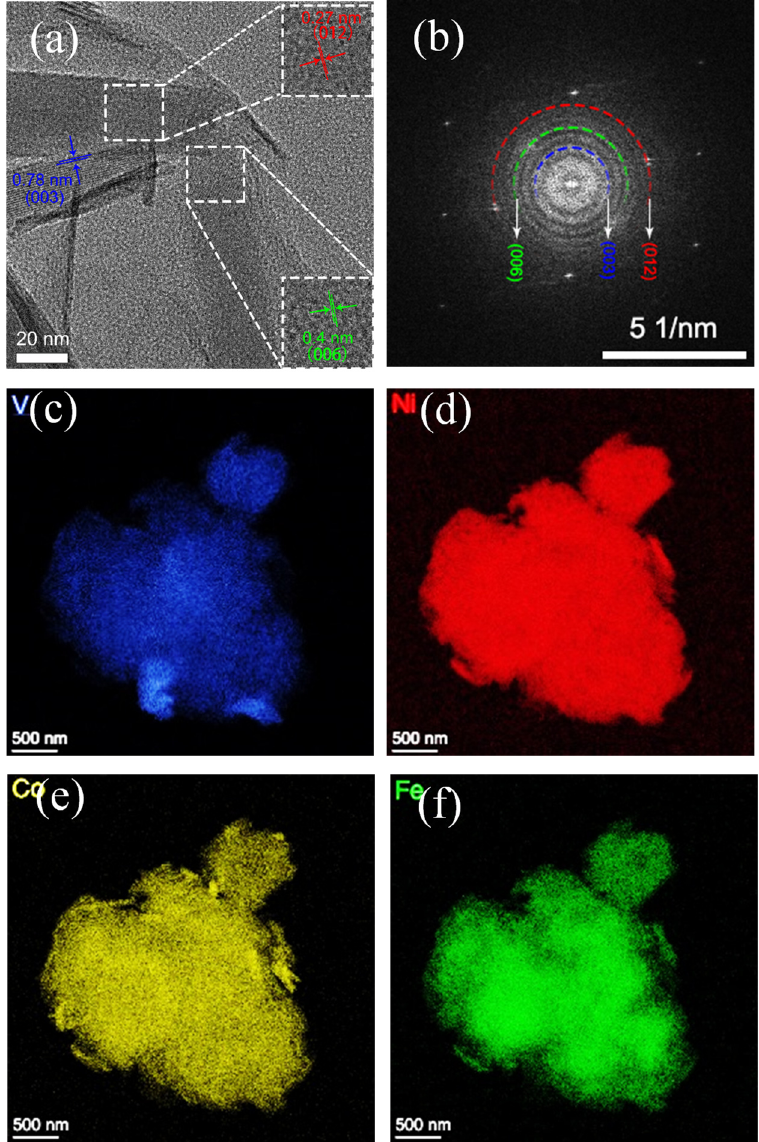
Figure 4. ( a ) HRTEM image; ( b ) SAED image; Elemental mapping of ( c ) V, ( d ) Ni, ( e ) Co, and ( f ) Fe in NiCoFe–LDH/V 2 CT x –MXene.